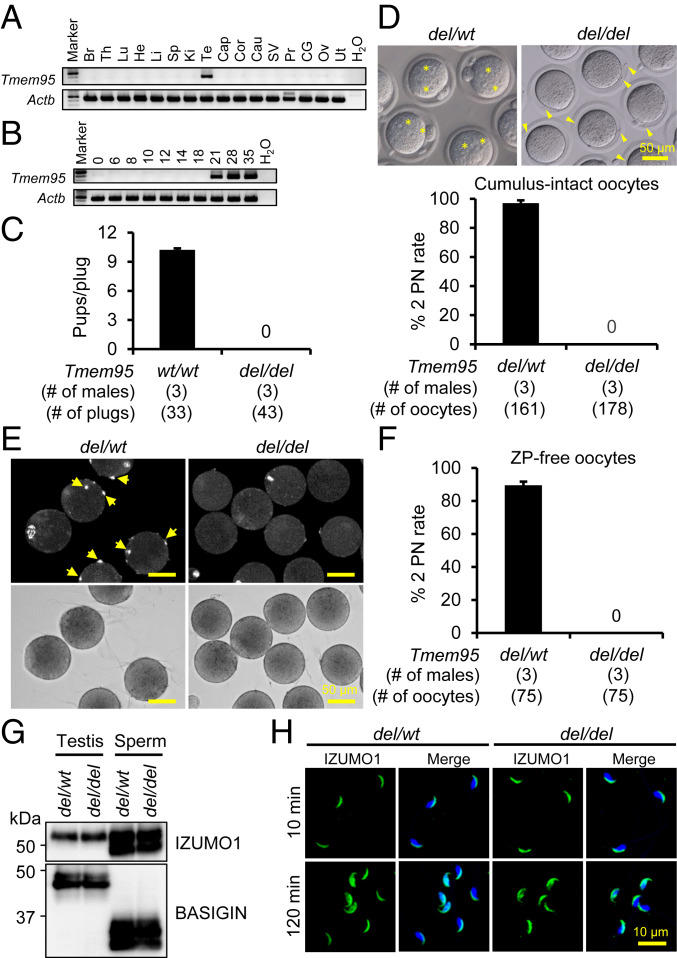
Analyses of Tmem95 del/del male mice. (A) Detection of Tmem95 mRNA in mouse tissues and organs by RT-PCR. (B) Detection of Tmem95 mRNA in mouse testes postnatally. (C) Analysis of the fecundity of Tmem95 del/del males by mating tests. Males were caged with wt/wt females for 10 wk, during which copulation plugs were examined and litter sizes were recorded. The wt/wt males were examined in the meantime as a positive control. During the mating test, while the wt/wt mating pairs delivered 337 offspring with an average litter size of 10.2 ± 1.9, the del/del males sire no pup. (D) IVF analysis of the ability of Tmem95 KO spermatozoa to fertilize cumulus-intact oocytes. (Upper) After 6 h of incubation, Tmem95 control spermatozoa successfully inseminated oocytes indicated by the formation of 2 PN (asterisks), whereas the KO spermatozoa were accumulated in the perivitelline space and cannot fertilize the oocytes (arrowheads). (Lower) The control spermatozoa give a high fertilization rate of about 97%. In contrast, no 2 PN eggs were observed when inseminated with the KO spermatozoa. (E) Analysis of the ability of Tmem95 KO spermatozoa to fuse with the oocyte plasma membrane. Spermatozoa were incubated with Hoechst 33342-preloaded oocytes for 30 min, and the membrane fusion was determined by the transfer of Hoechst 33342 fluorescence signal to fused sperm heads (yellow arrows). The lower bright-field images indicate both Tmem95 control and KO spermatozoa could bind normally to the oocyte surface. (F) IVF analysis of the ability of Tmem95 KO spermatozoa to fuse with ZP-free oocytes. While about 97% of the Tmem95 control sperm-inseminated oocytes formed 2 PN, the KO spermatozoa could not fuse with ZP-free oocytes at all. (G) Expression of IZUMO1 in Tmem95 KO spermatozoa. The expression of IZUMO1 was comparable in the testis and sperm lysates of Tmem95 del/wt and del/del males. The expression of BASIGIN was analyzed in parallel by immunoblotting as a loading control. (H) Localization of IZUMO1 in Tmem95 KO spermatozoa before and after the acrosome reaction. After 10 and 120 min of incubation in TYH medium, the localization of IZUMO1 in the control and KO spermatozoa was visualized by immunocytochemistry. Sperm nuclei were labeled by Hoechst 33342. Same as control sperm, IZUMO1 in the KO spermatozoa was localized to the acrosome cap before the acrosome reaction and translocated to the equatorial segment or the entire sperm head after the acrosome reaction.